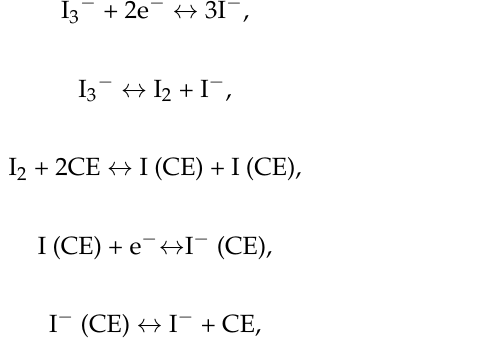
Figure 2. The schematic diagram of the electrochemical regeneration reactions of I 3 − ions at a counter electrode ( upper side ) and the related reaction equations ( bottom side ).